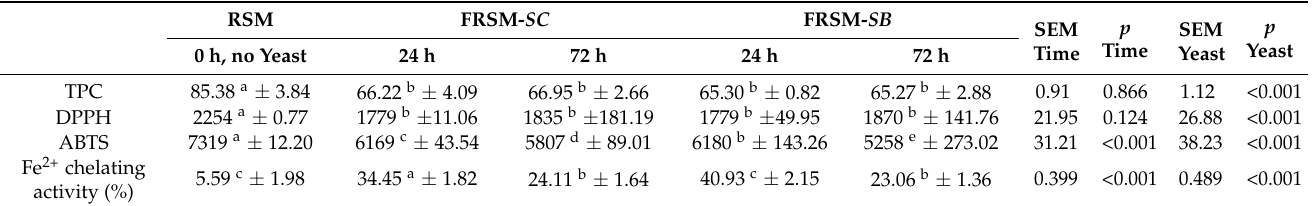
Table 3. The total phenolic compounds (TPC) and antioxidant activity (DPPH, ABTS, Fe 2+ chelating activity) in rapeseed meal